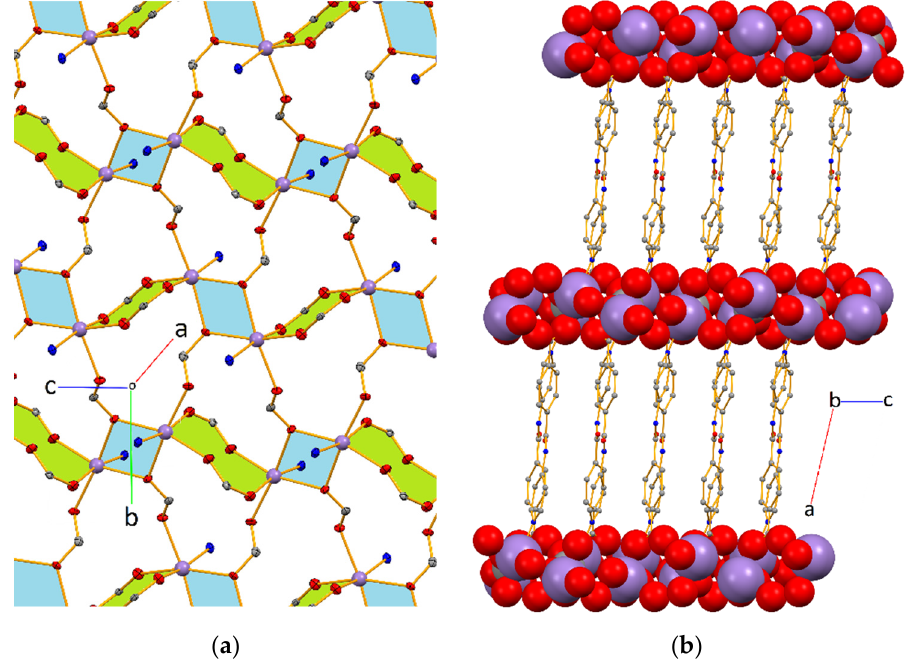
Figure 2. ( a ) A fragment of the infinite 2D layer in Mn-CP revealing chains of corner-shared eight- membered Mn 2 O 4 C 2 (in green) and four-membered Mn 2 O 2 (in blue) metallacycles, intercalated with sets of twelve-membered Mn 3 O 6 C 3 metallacycles (not highlighted). For clarity, the L – ligands are omitted, except for their O- and N-atoms that define the Mn coordination environments; the H-atoms of formate are also excluded. ( b ) A 3D packing is viewed down the crystallographic b axis; the